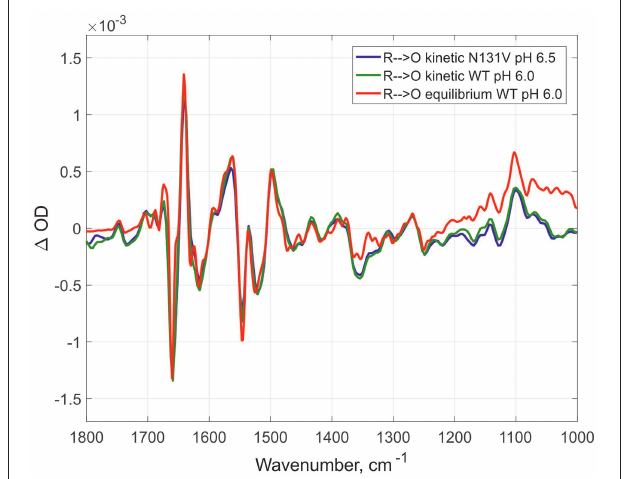
FIGURE 2 | Comparison of the R → O transitions in three different conditions. Time-resolved mode for N131V at pH 6.5 in dark blue and for WT at pH 6.0 in dark green; equilibrium mode for WT at pH 6.0 in red. All spectra normalized to 1mM (kinetic—by amplitude of 1,965 cm-1 band, equilibrium—by 1661/1641 peaks